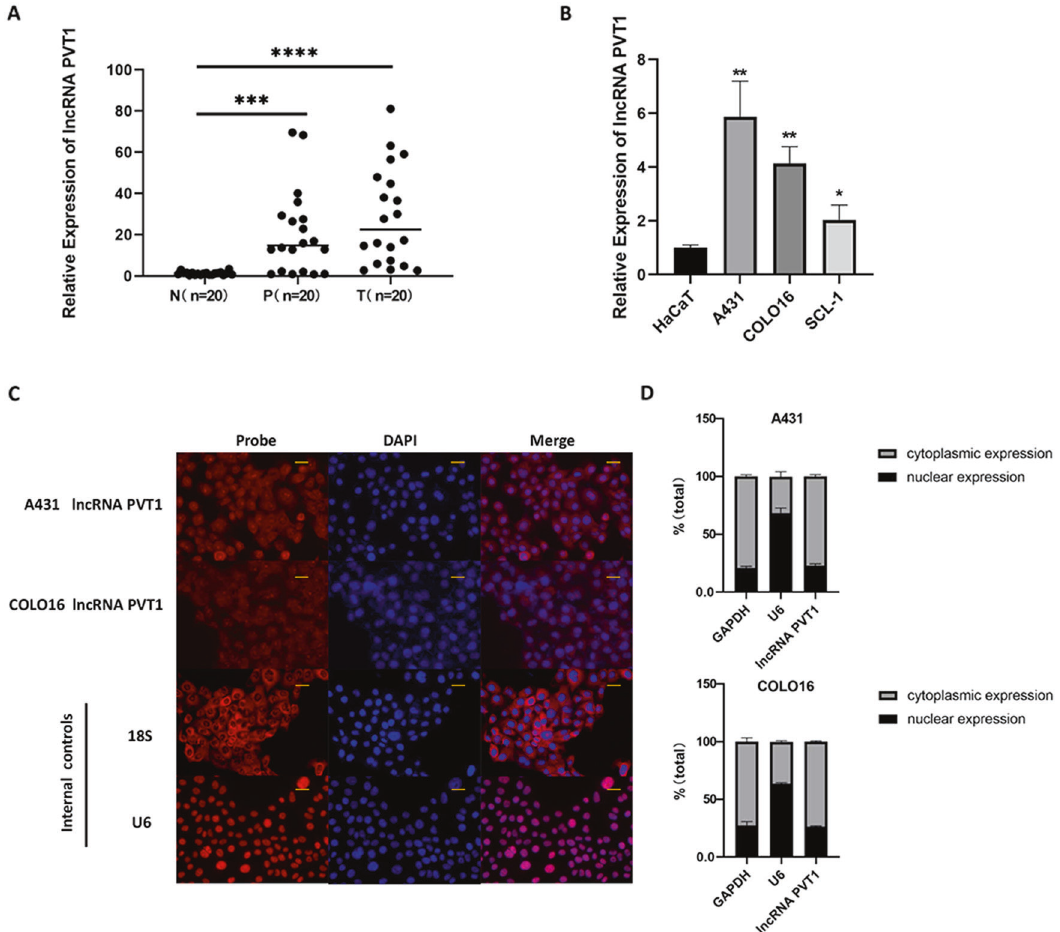
Fig. 1 LncRNA PVT1 is upregulated in human cSCC tissues and cells. A The expression level of lncRNA PVT1 is signi fi cantly elevated in clinical cSCC tissues and para-tumor tissues ( n = 20). B LncRNA PVT1 expression is highly upregulated in the three human cSCC cell lines A431, COLO16, and SCL-1. C Representative images of lncRNA PVT1 expression were taken by RNA-FISH in the A431 and COLO16 cell lines (×400 magni fi cation, scale bar = 25 µm). D Quanti fi cation of PVT1 distribution percentage was measured by nucleocytoplasmic fractionation, demonstrating that the lncRNA PVT1 was mainly distributed in the cytoplasm of A431 and COLO16 cell lines. T tumor, P paratumour. * P < 0.05, ** P < 0.01, *** P < 0.001, **** P < The 4E-binding protein 1 (4EBP1), belonging to a family of eukaryotic initiation factor 4E (eIF4E)-binding proteins, acts as a tumor suppressor by modulation the mammalian target of rapamycin (mTOR) pathway in some cancers, and may have additional oncogenic roles under other circumstances [17 – 19].